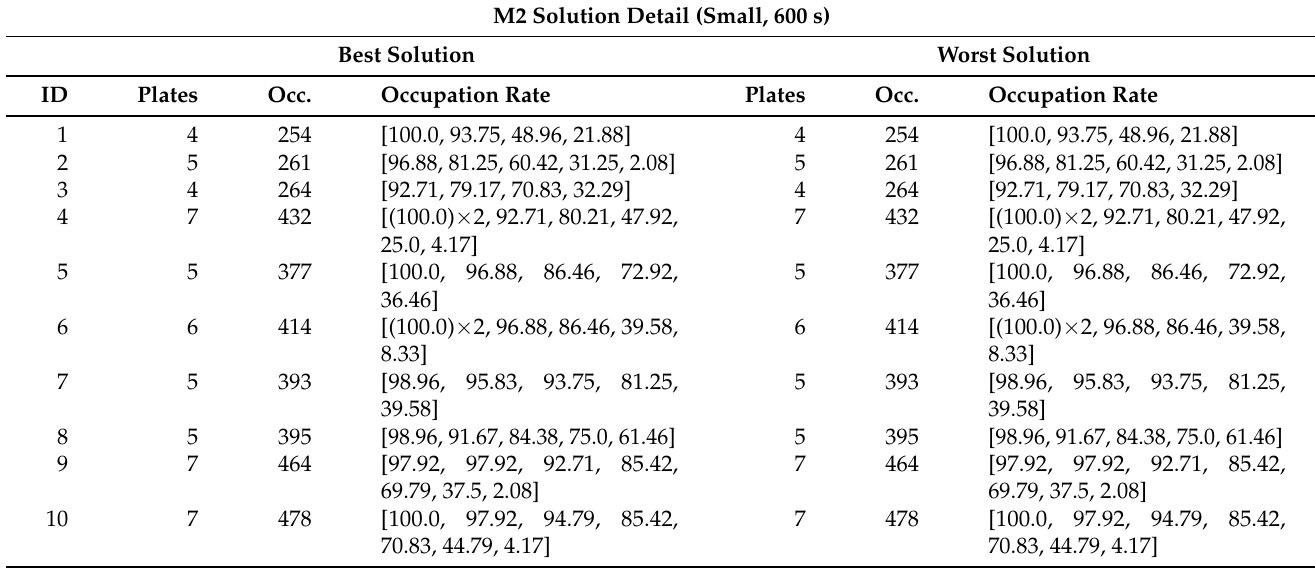
Table A14. M2 best and worst solutions obtained for small and medium files, limited to